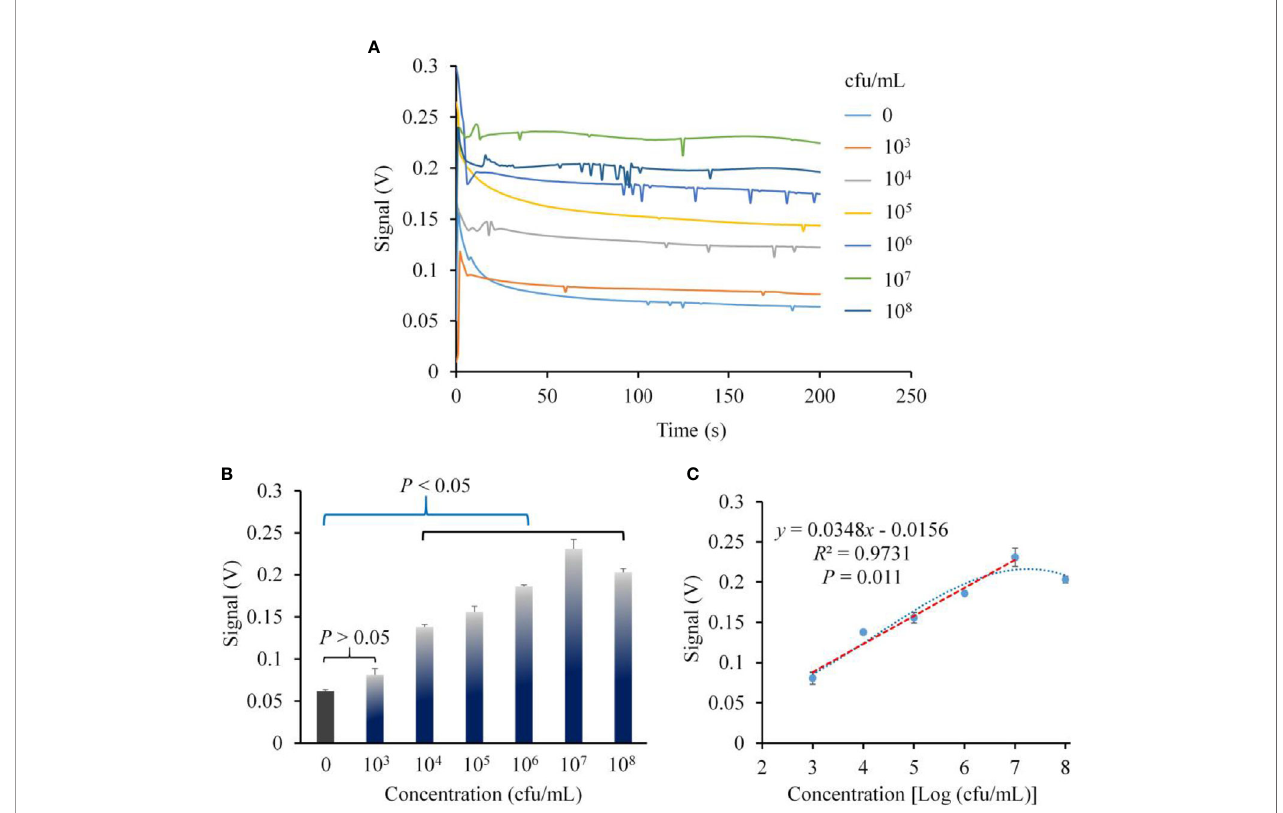
FIGURE 5 | The sensitivity of the biosensor for the detection of S. aureus . (A) Signal-time response trace during a complete test cycle (200 seconds, 200 s) with the bacterial concentration gradients from 0 to 10 8 CFU/ml, and the signals value at the 200 s were applied to the statistical analysis in (B) and (C, B) The optimal signal detection values of the fl uorescence intensity of S. aureus at various concentration gradients and their statistical analysis showed that the sensitivity was 10 4 CFU/ml. (C) The linear regression curve of signal versus the logarithm of the S. aureus concentration gradients. There was a signi fi cant positive linear correlation relationship with the fl uorescence intensity in the range of 10 3 – 10 7 CFU/ml concentration (correlation coef fi cient R 2 = 0.9731, P = 0.011). Error bars in (B, C) are based on standard deviations (n =